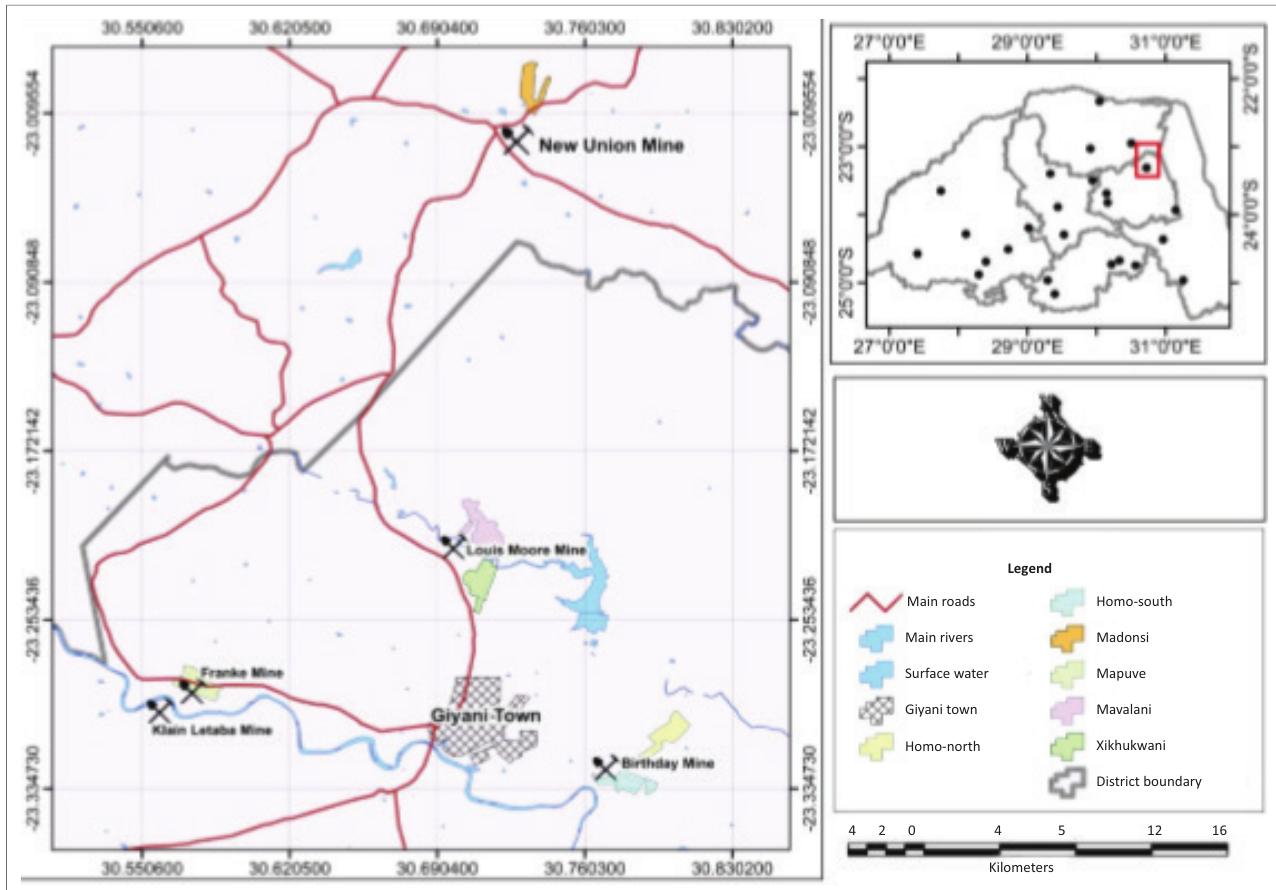
FIGURE 1: The location of the studied abandoned mines in the Giyani area.